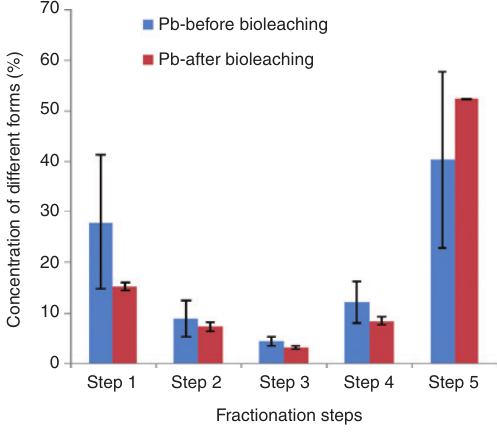
Figure 8: Variation in the partitioning of chemical forms for Cr (VI) before and after the one-step bioleaching